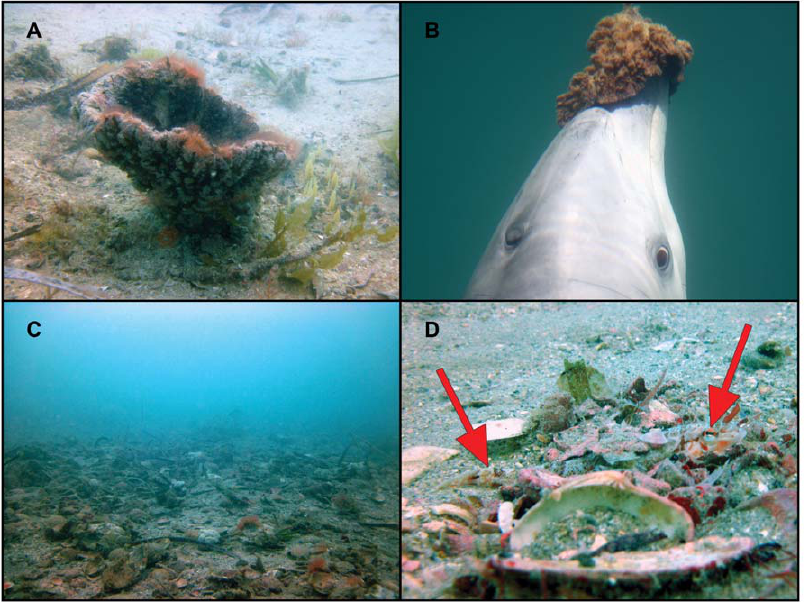
Figure 1. Sponging in Shark Bay. ( A ) marine basket sponge ( Echinodyctium mesenterinum ), ( B ) dolphin wearing a sponge on its rostrum, ( C ) substrate littered with rock, shell, and debris, ( D ) hiding prey, barred sandperch ( Parapercis nebulosa ). All photographs taken by Eric M. Patterson.